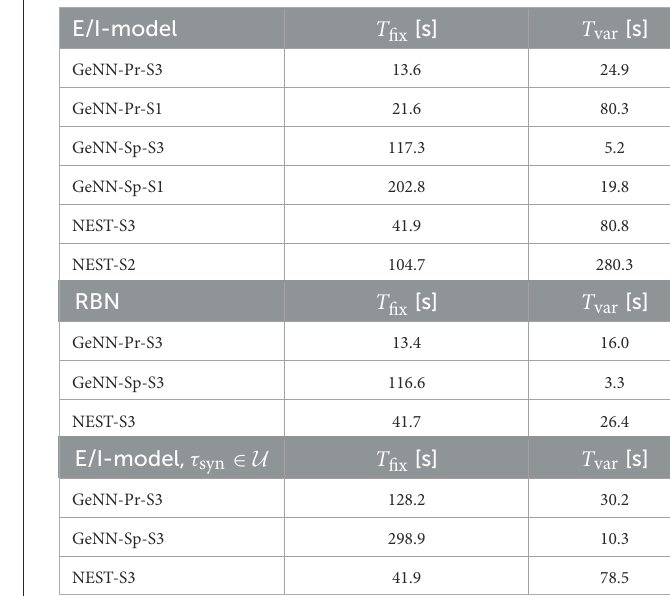
TABLE 3 Fixed costs ( T fix ) and variable costs ( T var ) for simulating networks of size N = 50.000 during 10s of biological model